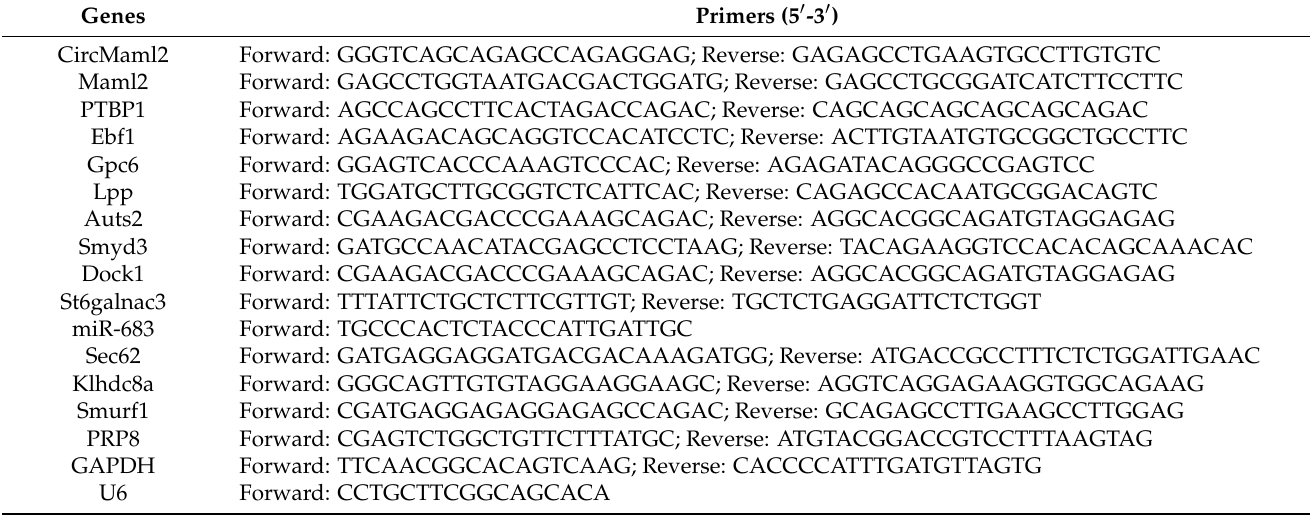
Table 1. Relative